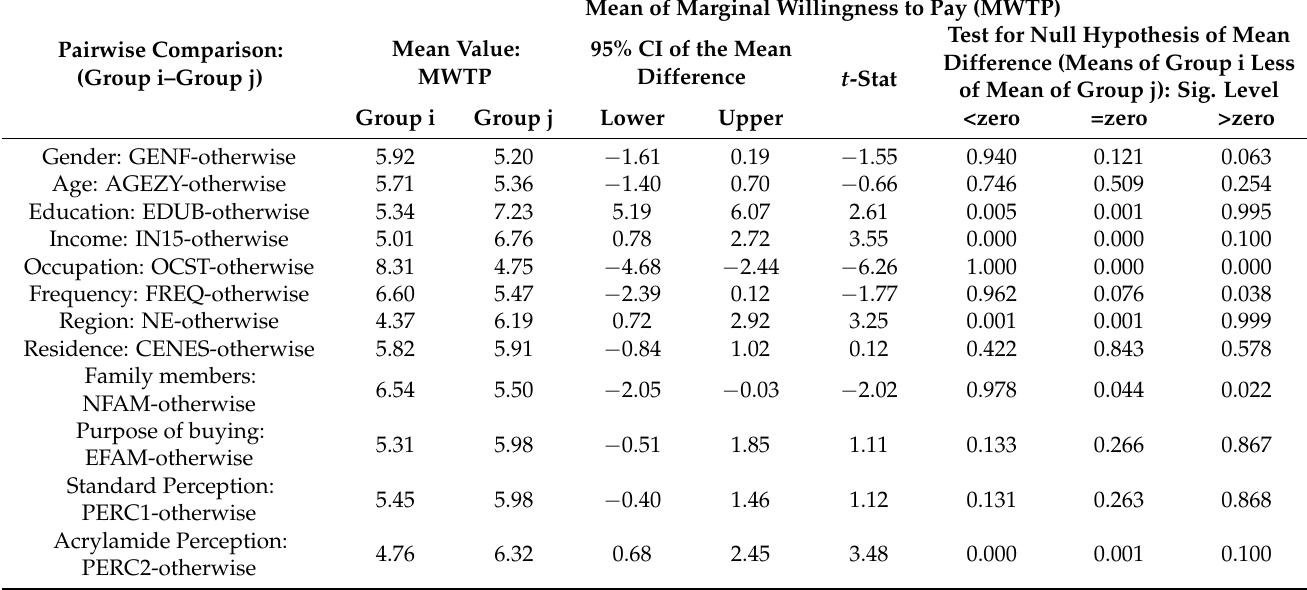
Table 5. Paired sample t -test on the average determining